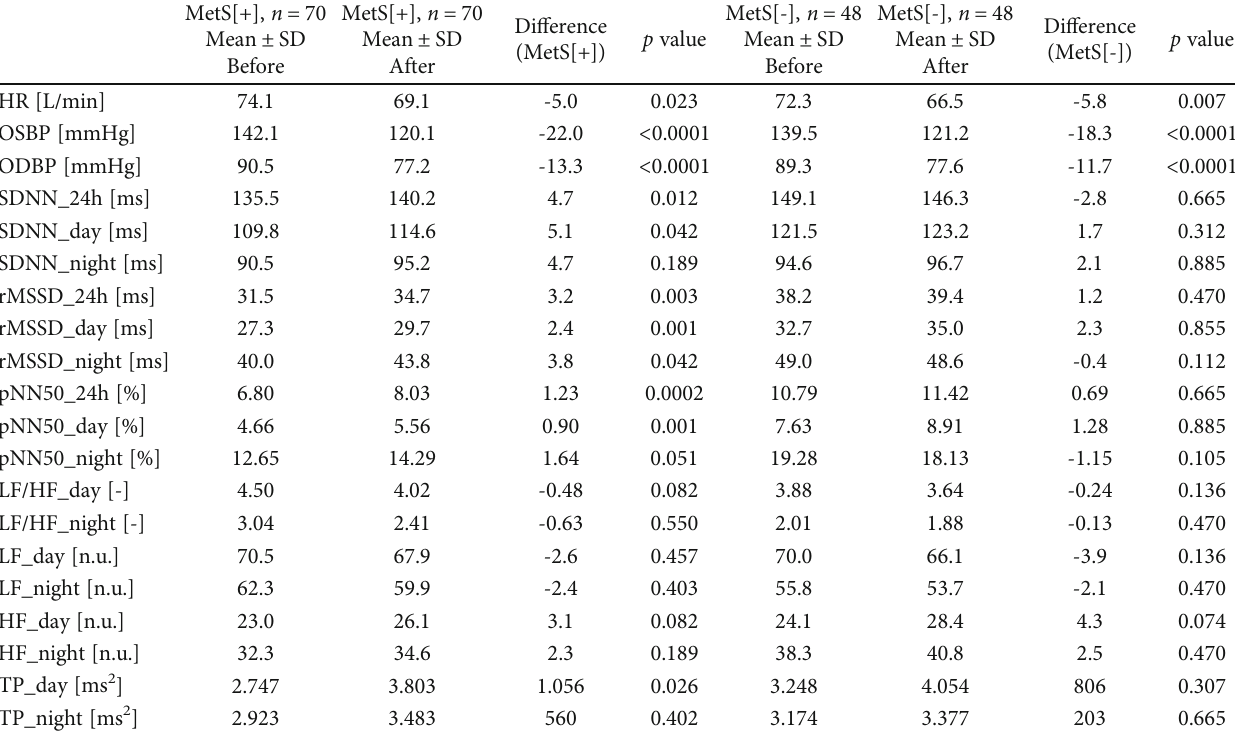
Table 3: Comparison of HRV parameters before and after 12-month treatment, in patients with HTN strati fi ed by concomitant MetS. MetS[+], n = 70 MetS[+], n = 70 Mean ± SD Mean ± SD Before After Before